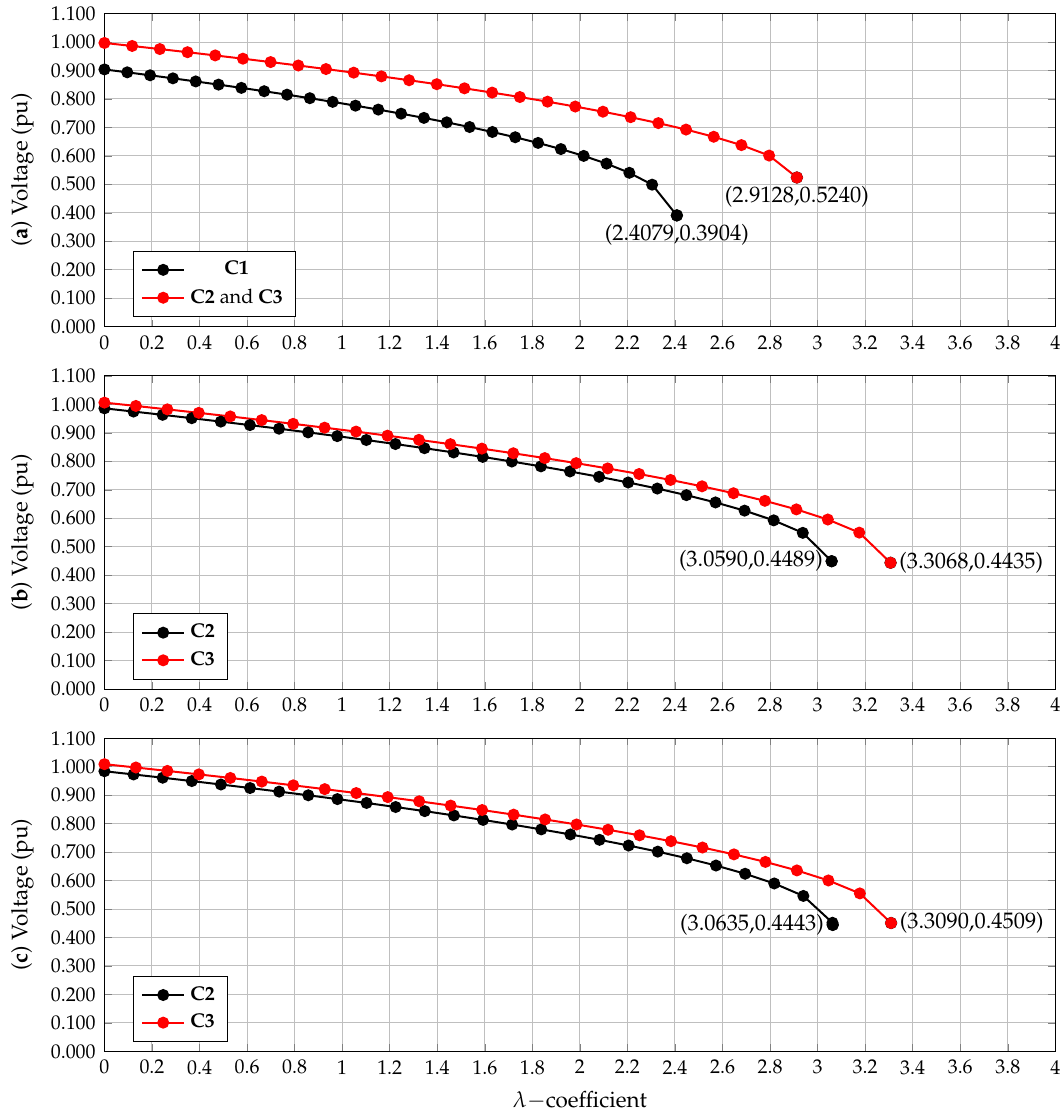
Figure 6. Voltage performance at node 18: ( a ) benchmark case and C2 and C3 with one dispersed generator, ( b ) C2 and C3 with two dispersed generators, and ( c ) C2 and C3 with three dispersed